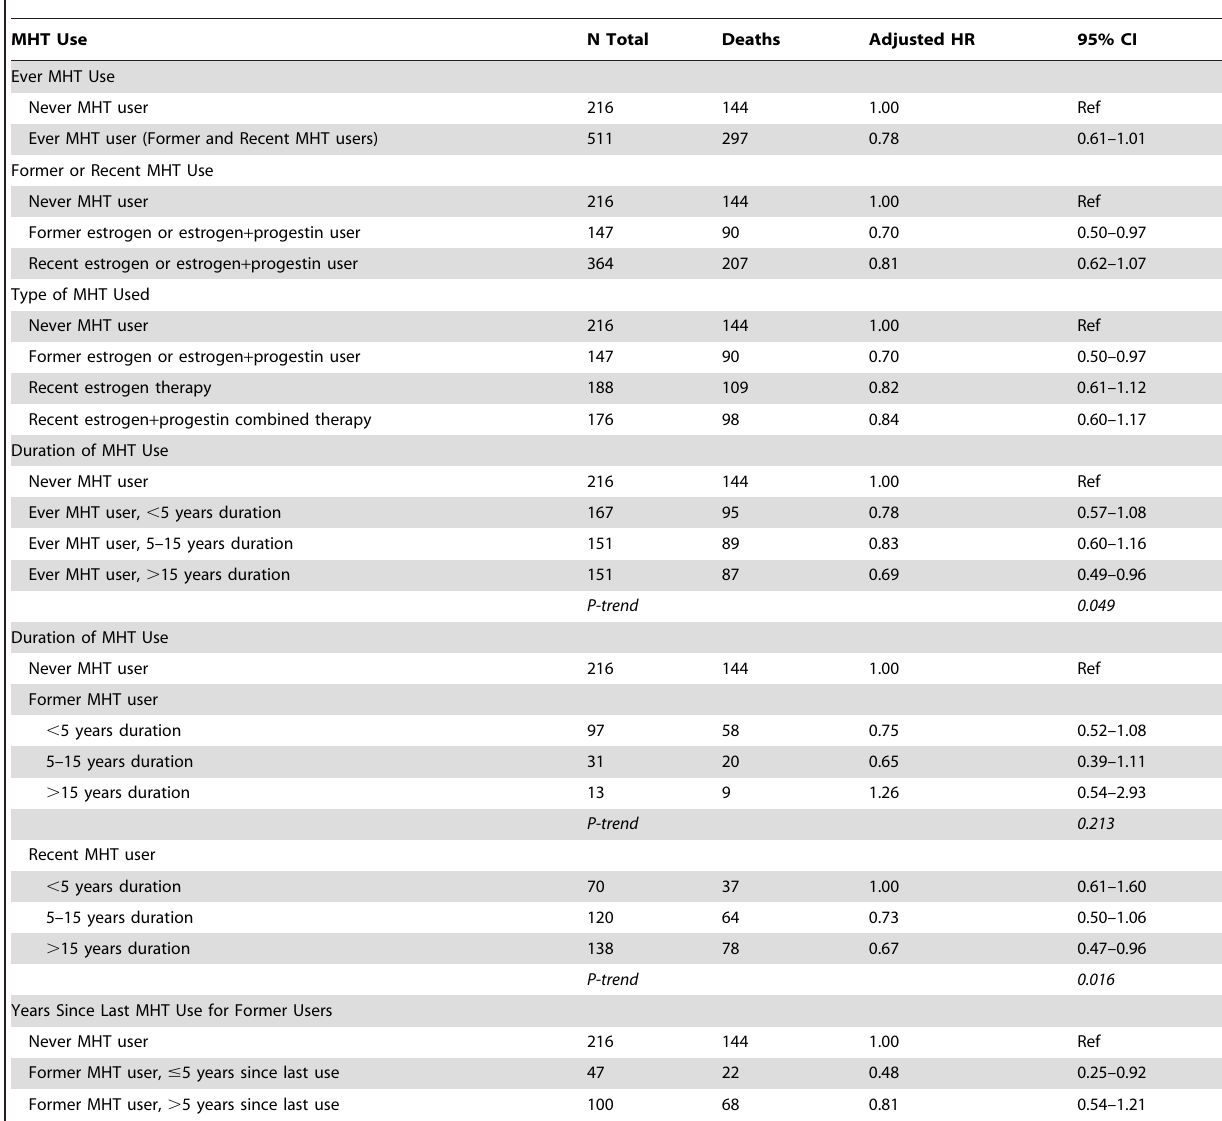
Table 2. Adjusted 1 hazard ratios (HR) and 95% confidence intervals (CI) for the association between menopausal hormone therapy (MHT) use and mortality among 727 postmenopausal women diagnosed with lung cancer following enrollment in the California Teachers